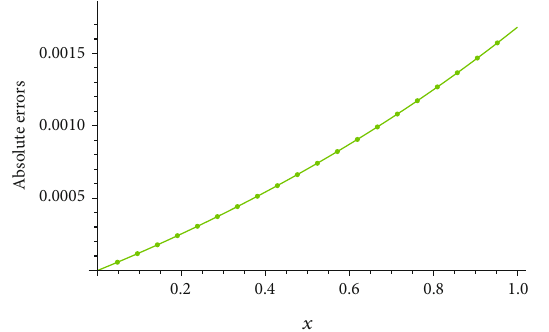
Figure 30: Absolute errors of u Example